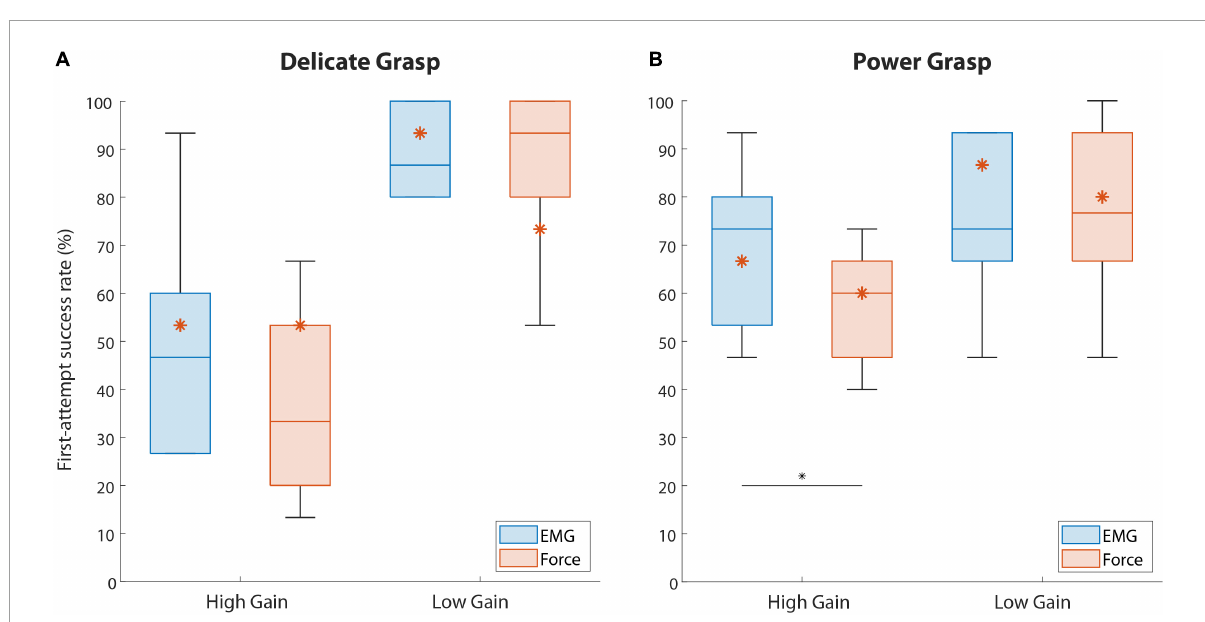
FIGURE6 The percentage of trials successful in the first attempt (first-attempt SR), for both force targets. Boxplots (A,B) correspond to delicate and power grasps, respectively. The blue and red boxplots represent the summary performance with EMG and force feedback, respectively. The orange asterisks denote the performance of the amputee subject. The boxplots indicate the median (horizontal line), interquartile range (boxes), min/max values (whiskers), and outliers (circles). Statistically significant pairs are marked with horizontal bars ( ∗ p < 0.05). “High Gain” and “Low Gain” denote the disturbance